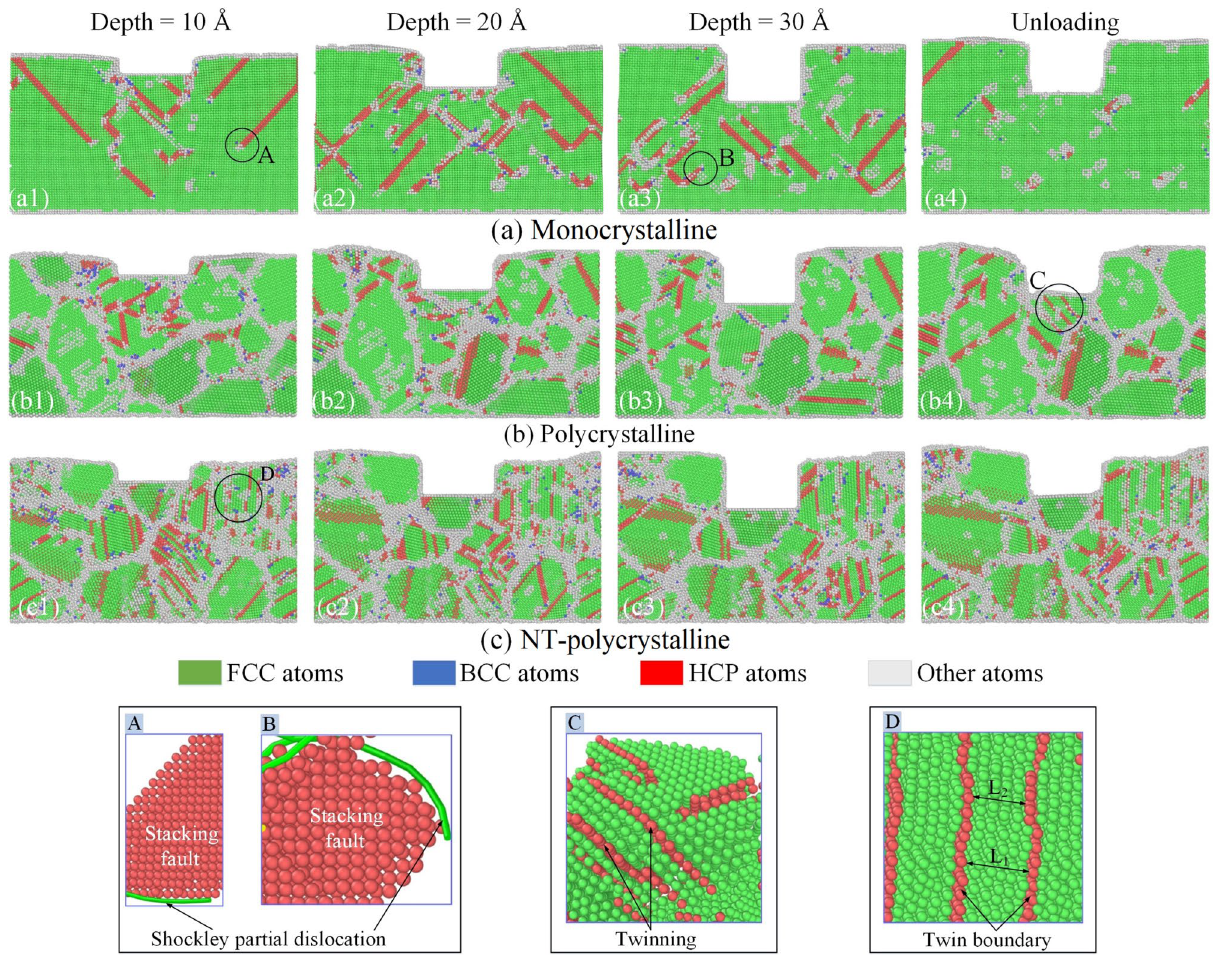
Figure 5. The evolution of microstructure at the various imprinting depths and the unloading stage of the Al0.5 HEA for different structures: monocrystalline ( a1 – a4 ); polycrystalline ( b1 – b4 ); and NT-polycrystalline ( c1 – c4